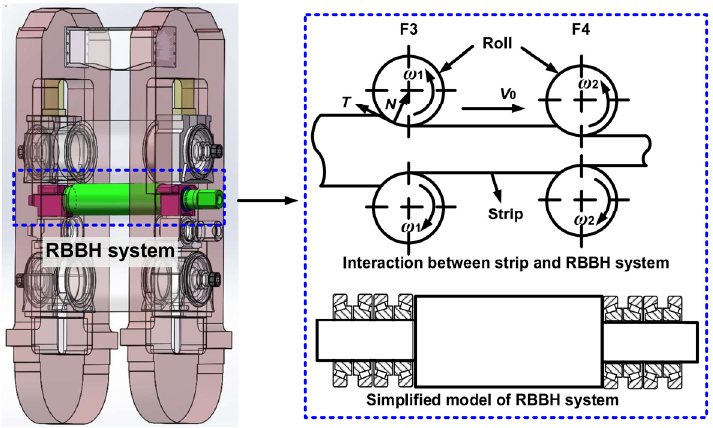
Figure 2. Analysis model of the RBBH system.